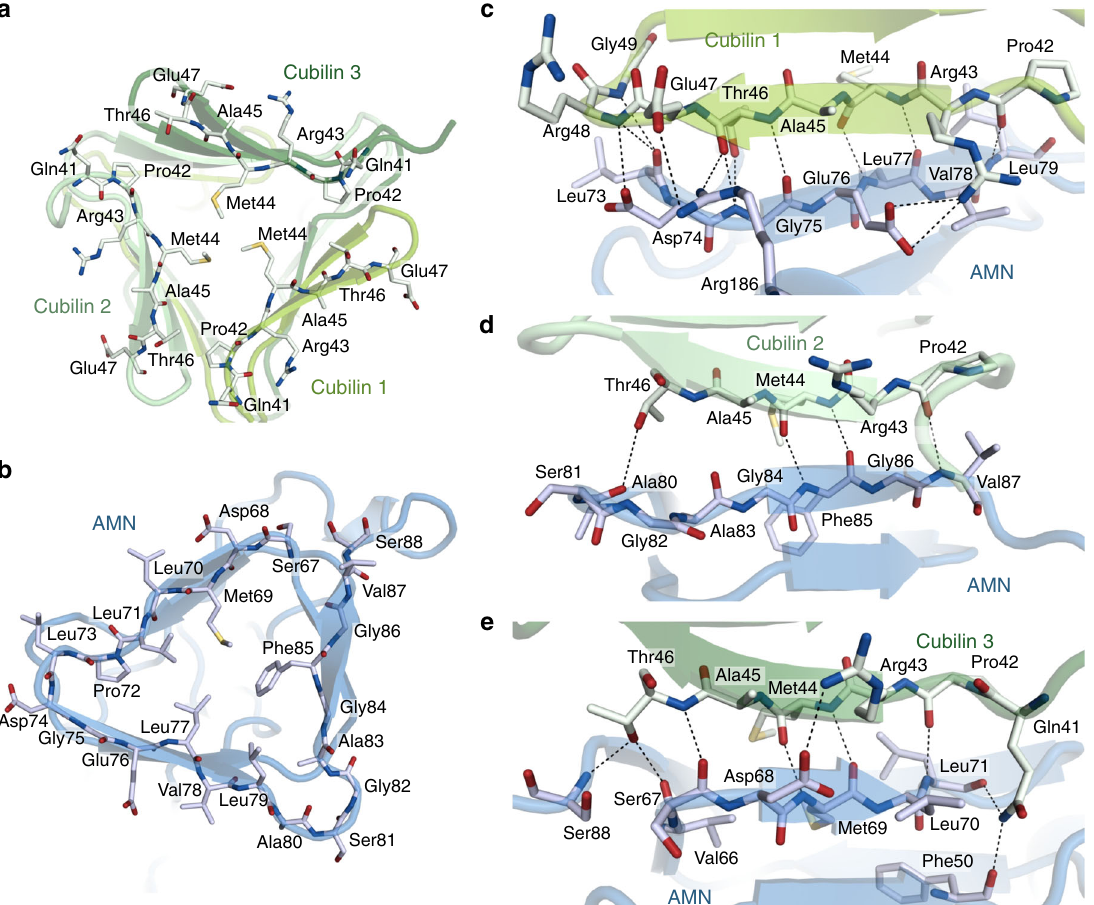
Fig. 2 Interaction between AMN and cubilin. a AMN interface of the trimeric cubilin β -helix. The hydrophobic centre of the β -helix is formed by Met44 residues. b Cubilin interface of AMN. AMN in b is related to cubilin in a by a vertical rotation of 180°. c – e Interactions between the three individual polypeptide chains of cubilin with AMN. Residues directly involved in interactions are shown as sticks. Hydrogen bonds and ionic interactions are marked by dashed black